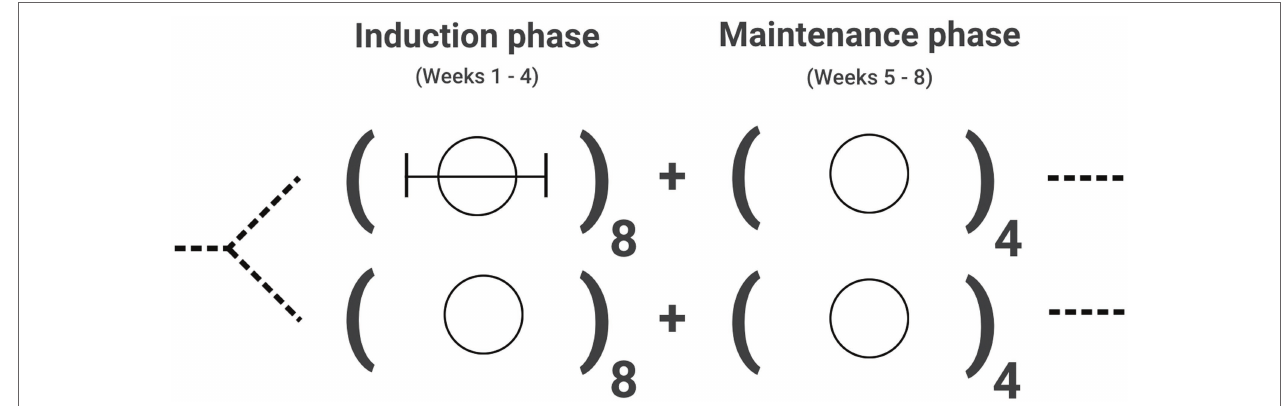
FIGURE 2 | Proposed design for a pilot investigation of esketamine with Acceptance and Commitment Therapy (ACT) for treatment-resistant depression. Current esketamine dosing protocols call for twice weekly dosing during a 4-week induction phase, followed by weekly dosing during a maintenance phase in weeks 5 through 8. Patients receive an initial dose of 56 mg, followed by repeated doses of 56 mg or 84 mg based on treatment response (i.e., efficacy and tolerability). After initial study procedures, participants will be randomized to receive treatment as usual (plain circle) or esketamine in conjunction with ACT (circle with bracketed line) during the induction phase of treatment. Both study arms will follow the same clinical procedures for maintenance treatment and subsequent